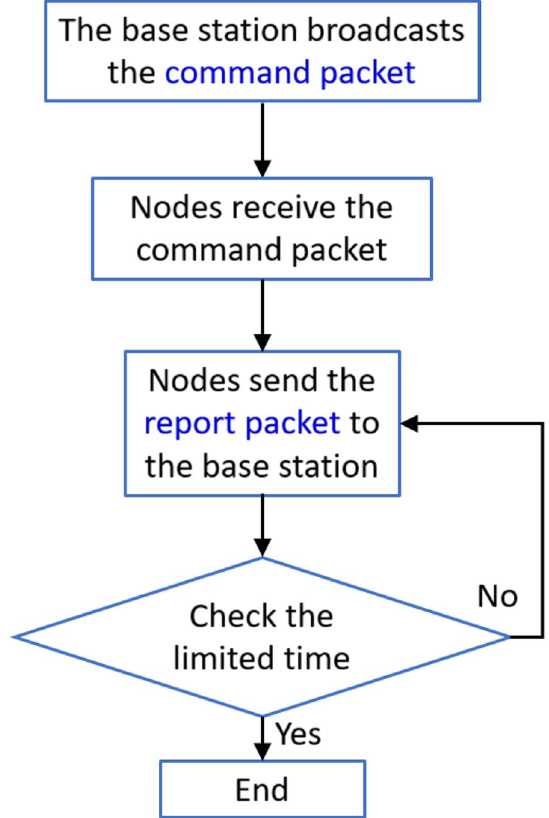
Fig. 3 Flowchart of WBAN